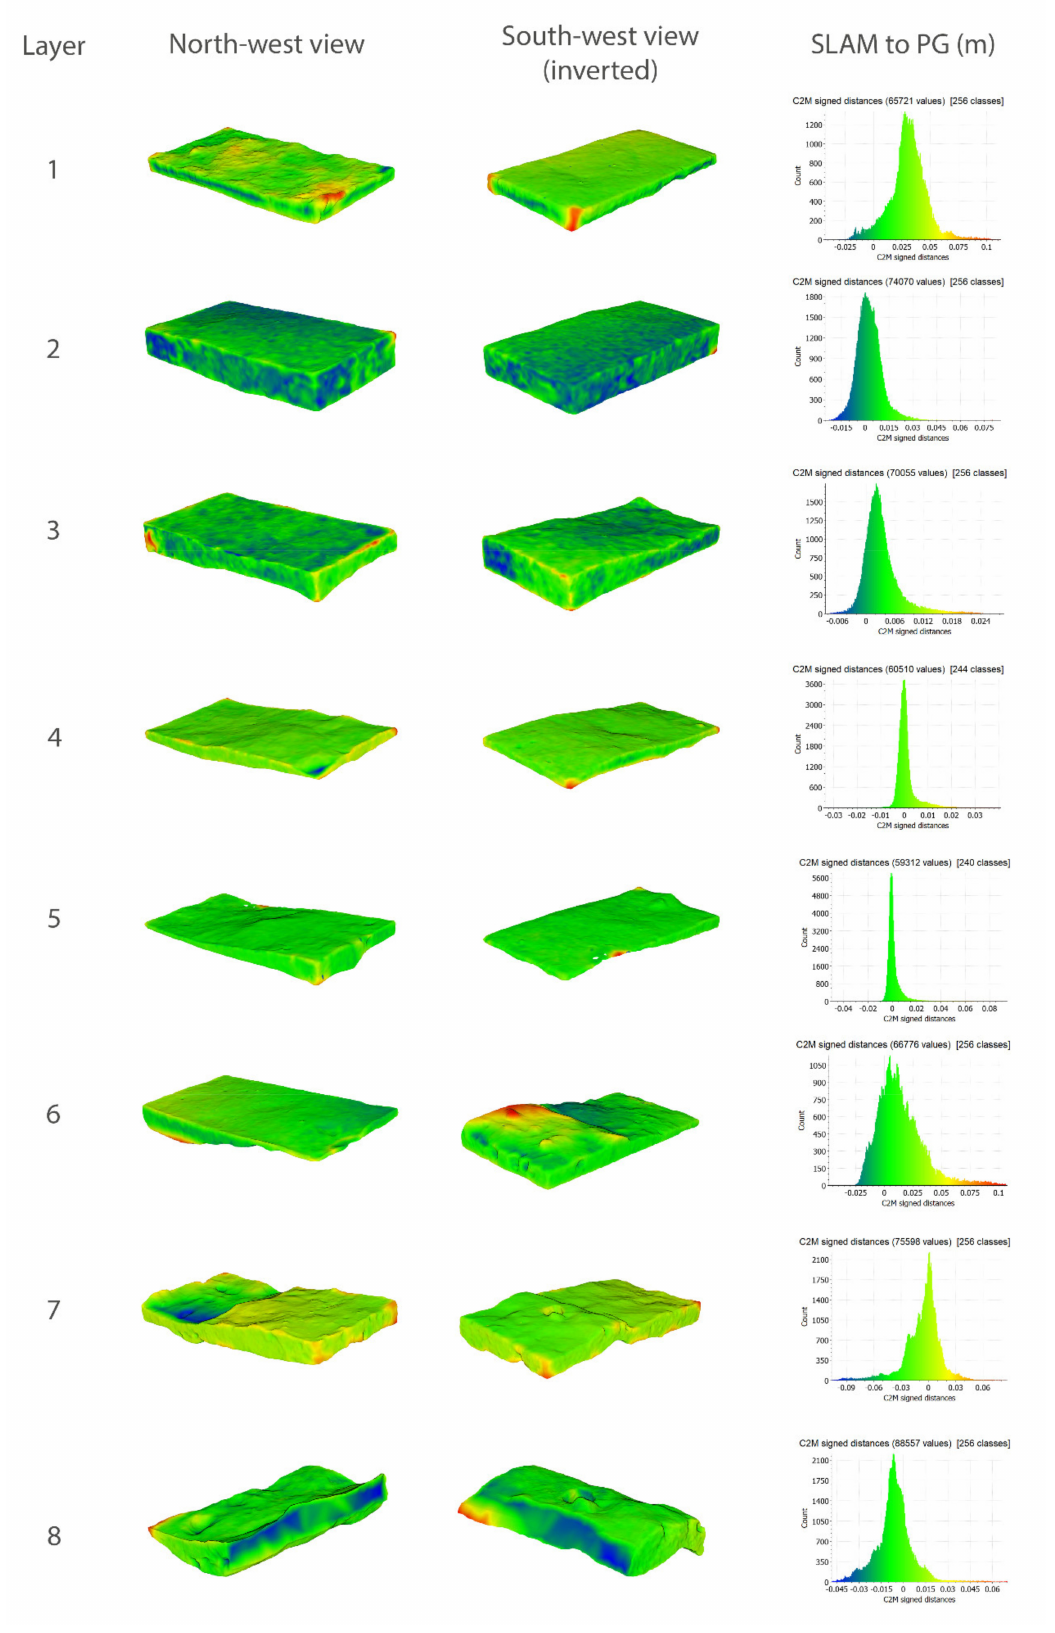
Figure 6. Comparison of the SLAM mesh onto the PG mesh by